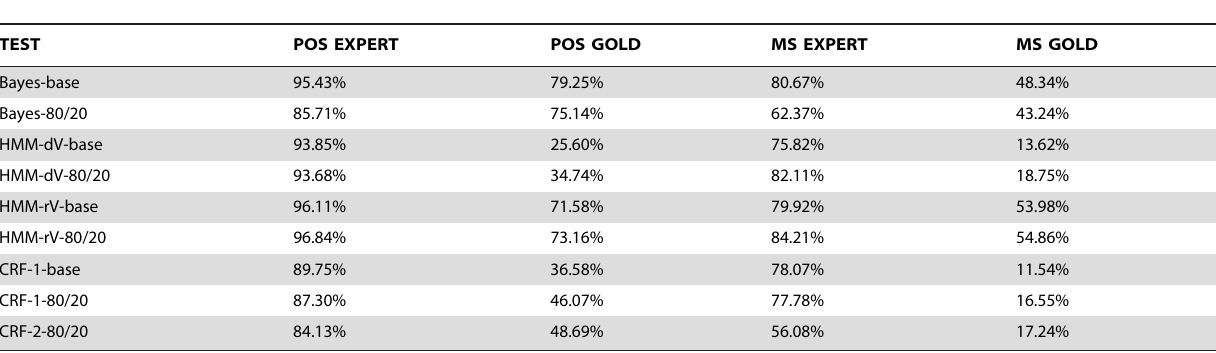
Table 7. Accuracies for POS and MS